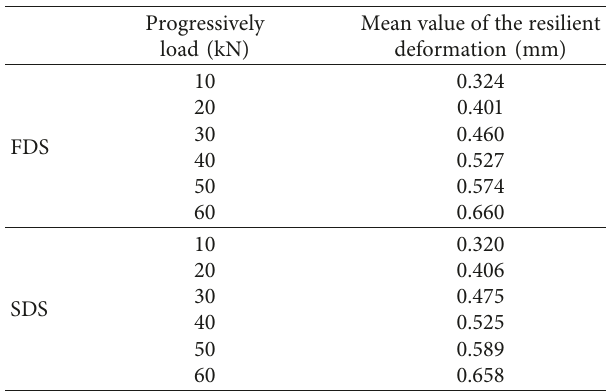
Table 11: The test results of CRM.